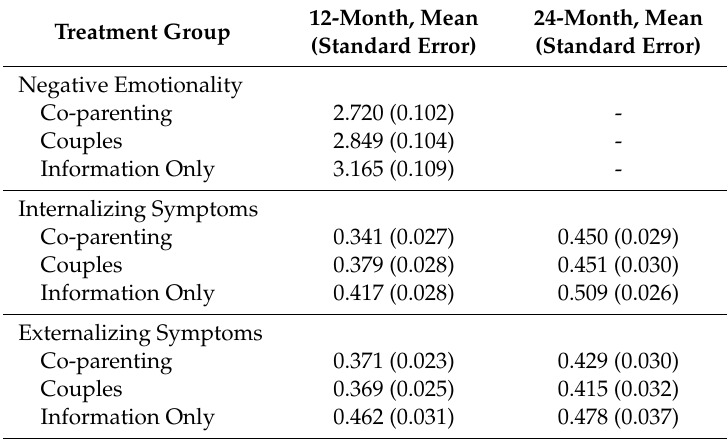
Table 1. Estimated marginal means and standard errors on temperament, externalizing, and internalizing variables per group.